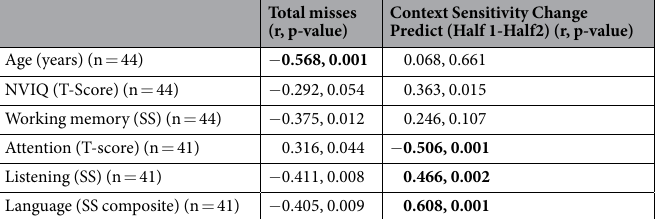
Table 2. Correlations for the Total misses and Context Sensitivity Change scores with Age, NVIQ, Working memory (digit span backwards), Attention, Listening (SAP), and Language (GCC). (Pearson’s 2-tailed tests, corrections Holm-Bonferroni, p-value < 0.05